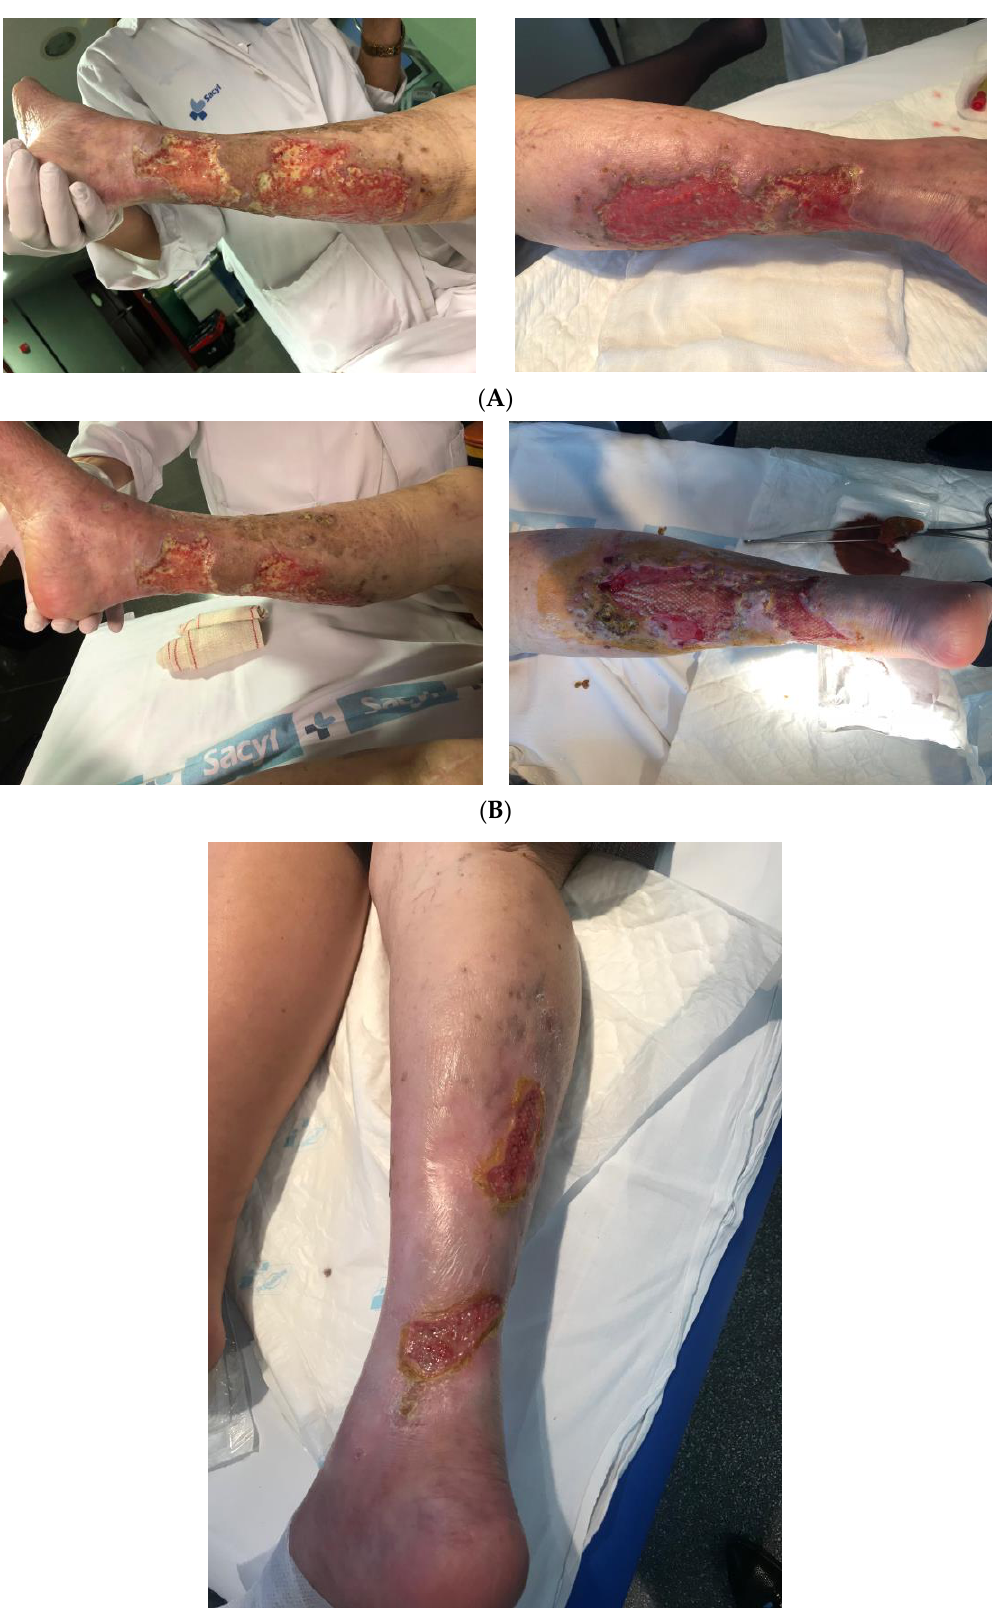
Figure 2. Example of wound healed completely (left, week 0; middle, week 7; right, week 12).